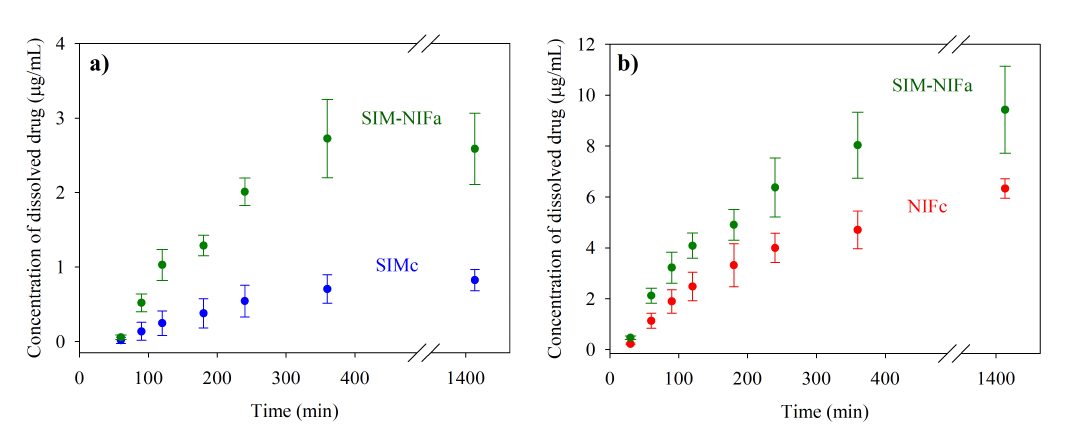
Figure 6. Dissolution profiles in USP Phosphate Buffer pH 6.8 for pure crystalline APIs (SIMc and NIFc) and co-amorphous formulation SIM-NIF: ( a ) solubility for SIM ( b ) solubility for